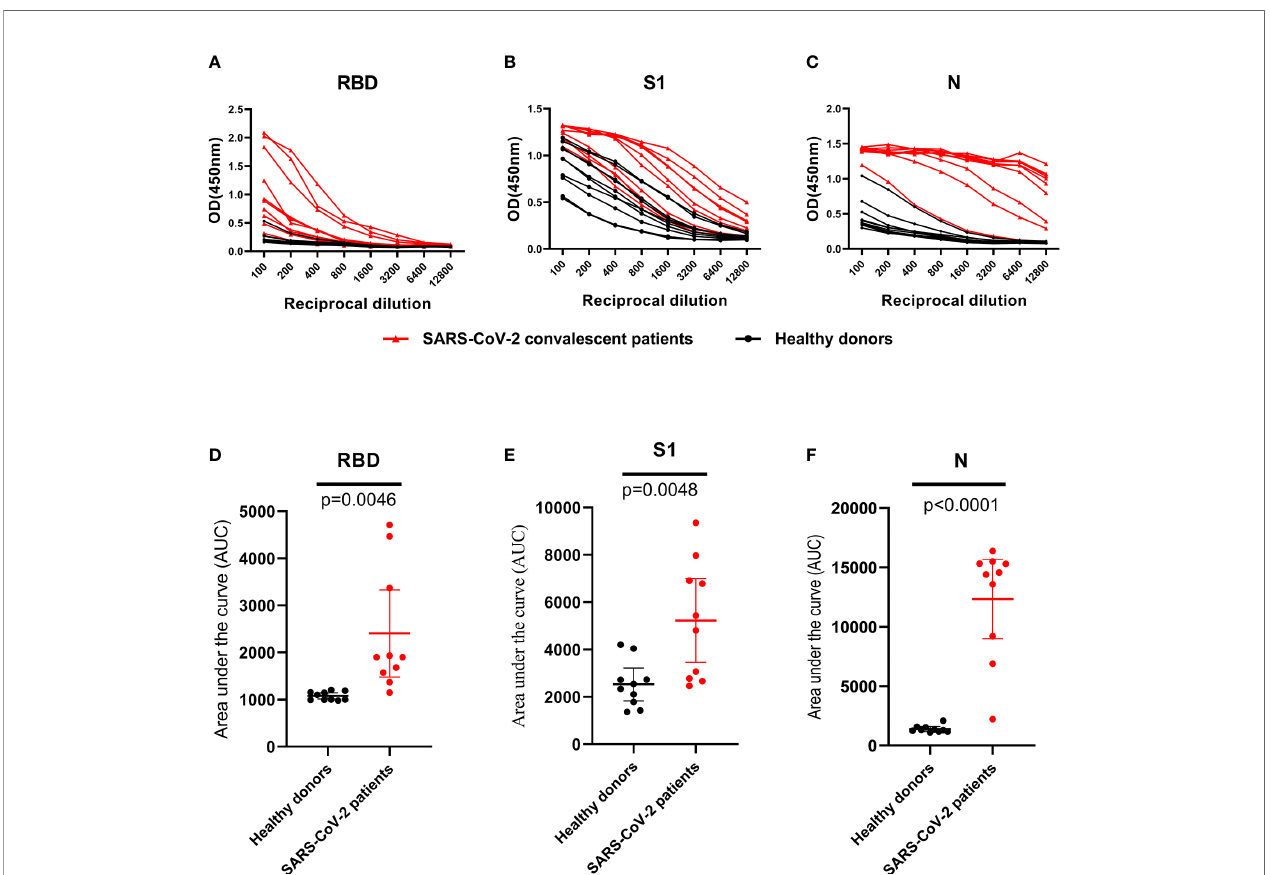
FIGURE 3 | IgG antibodies response against RBD, S1 and N protein in control and SARS-CoV-2 convalescent plasma. (A – C) , OD 450 values of IgG antibodies against RBD, S1 and N protein in randomly selected healthy donors (n=10; black dot and line) and SARS-CoV-2 convalescent plasma (n=10; black triangle and red line). (D – F) , Data from the same samples in (A – C) , respectively, but plotted by AUC mean with 95% CI. Statistical analyses were performed using corresponding unpaired two-tailed Student ’ s t test. Horizontal lines represent mean values.